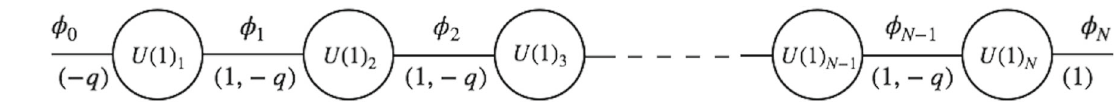
Fig. 1 Abelian quiver of the